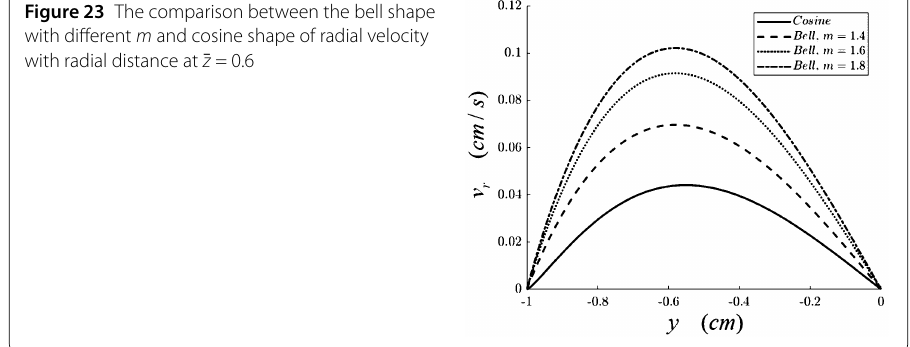
Figure 24 The comparison between the bell shape with different m and cosine shape of radial velocity with axial distance at y =